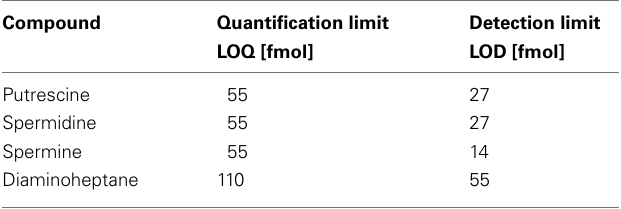
Table 1 | Detection limits of FMOC-derivatized